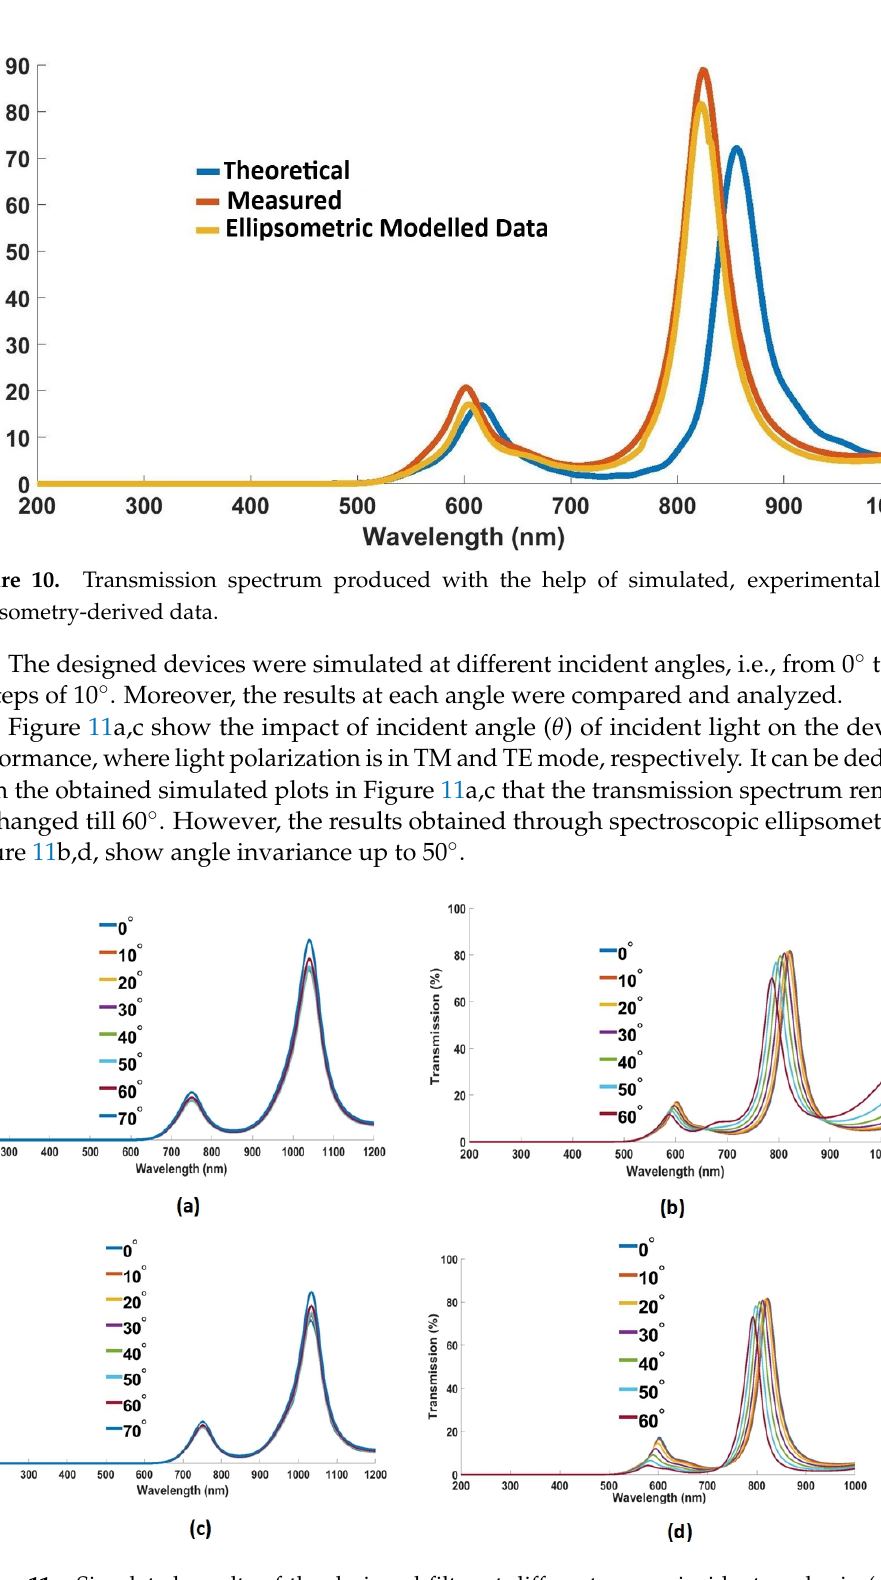
Figure 11. Simulated results of the designed filter at different source incident angles in ( a ) TM and ( c ) TE polarization mode. Transmission profile at different incident angles the incident light in ( b ) TM and ( d ) TE mode obtained with the help of spectroscopic